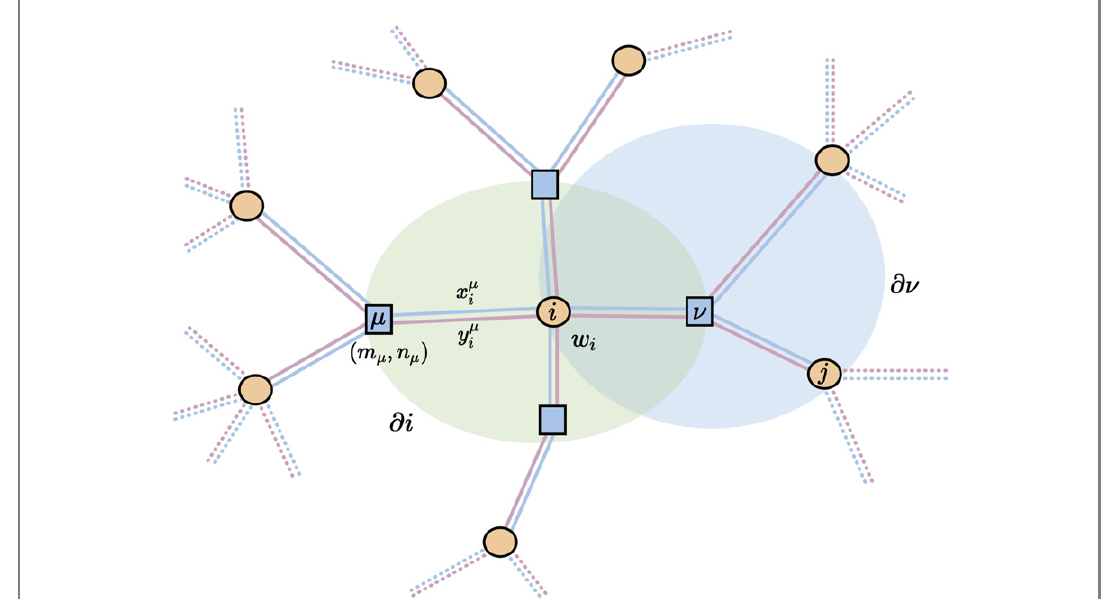
Figure1. Bipartite graph representation of a locally-tree like matrix F